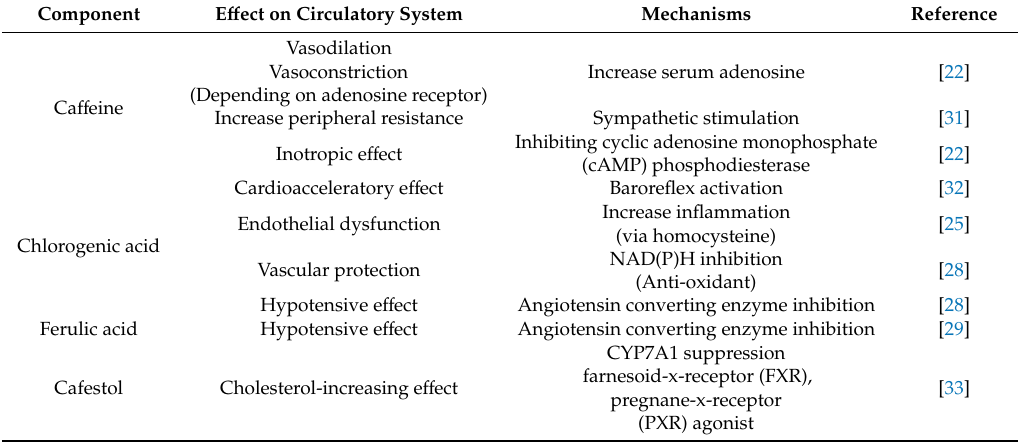
Table 1. General e ff ects of major compounds derived from co ff ee on the circulatory